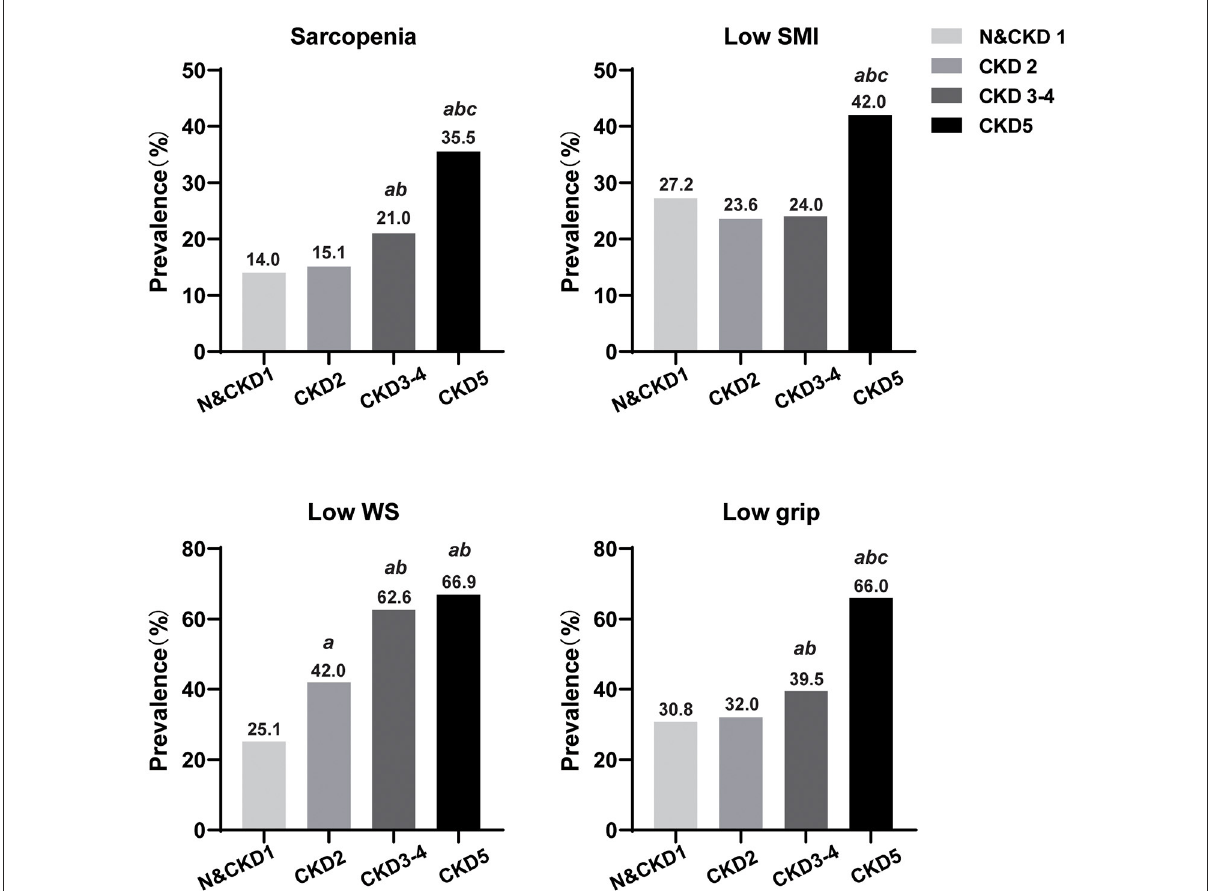
FIGURE1 Prevalence of sarcopenia and its components according to chronic kidney disease stage. N, normal; CKD, chronic kidney disease; SMI, skeletal muscle mass index; WS, walking speed. a Compared with normal and CKD 1 groups, P < 0.05; b Compared with CKD 2 groups, P < 0.05; c Compared with CKD 3–4 groups, P <